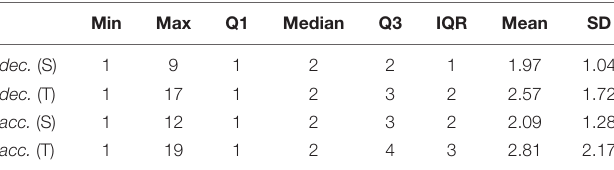
TABLE 6 | Descriptive statistics of length of monotonic RR sequences extracted from 5-min ECG recordings in supine and tilt